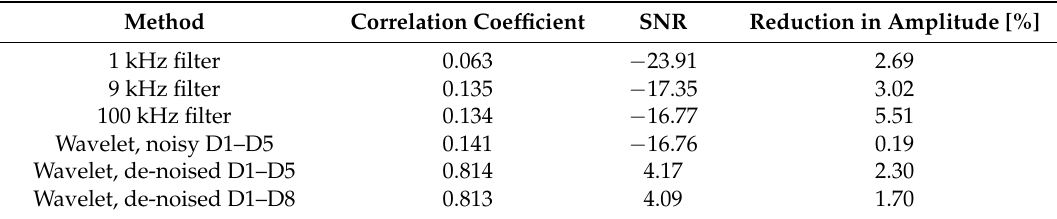
Table 1. Results of disturbance elimination. SNR: signal–noise